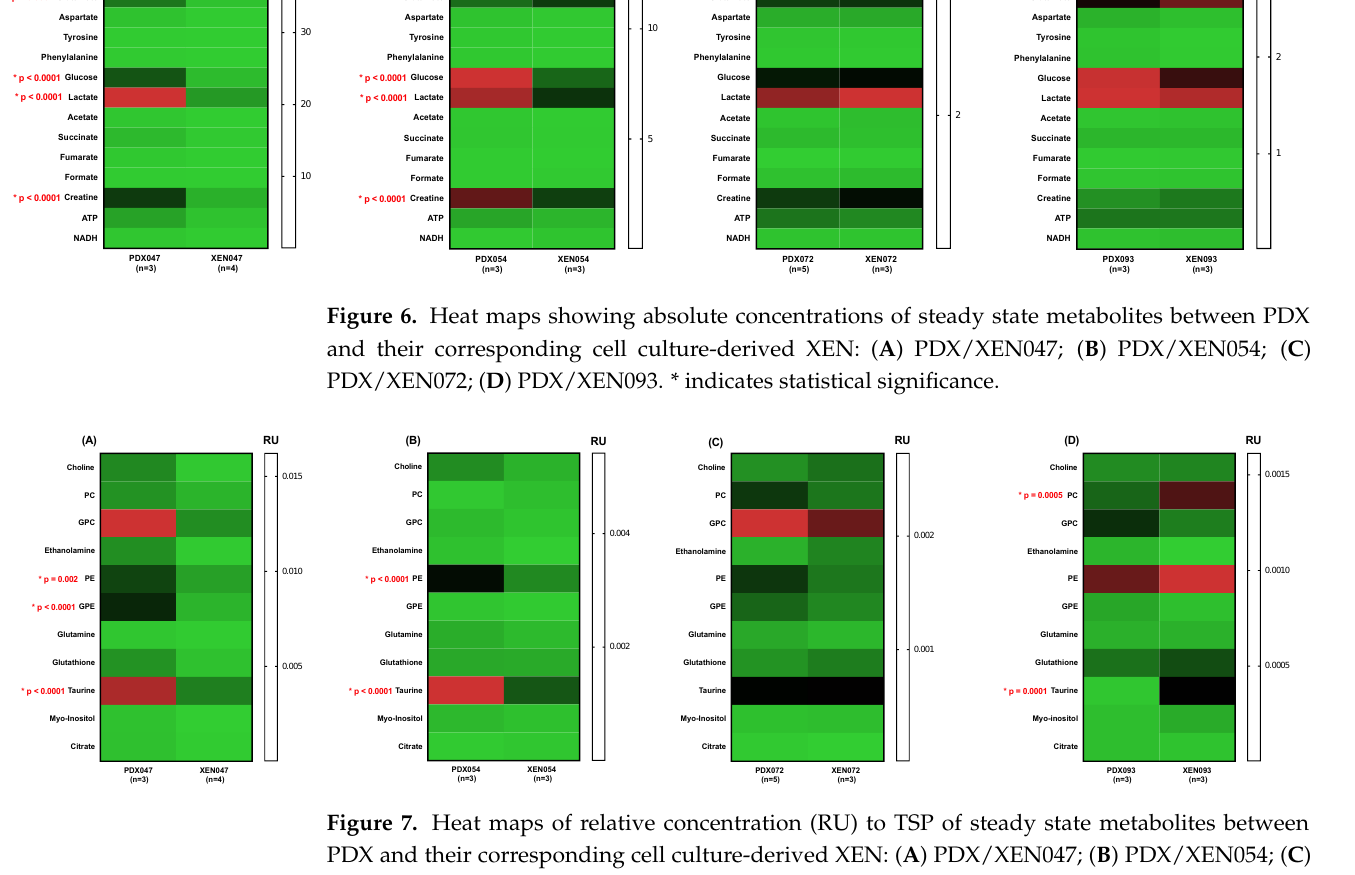
Figure 7. Heat maps of relative concentration (RU) to TSP of steady state metabolites between PDX and their corresponding cell culture-derived XEN: ( A ) PDX/XEN047; ( B ) PDX/XEN054; ( C ) PDX/XEN072; ( D ) PDX/XEN093. * indicates statistical significance